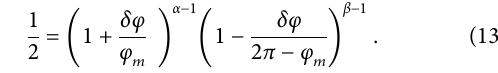
Frontiers in Physics |